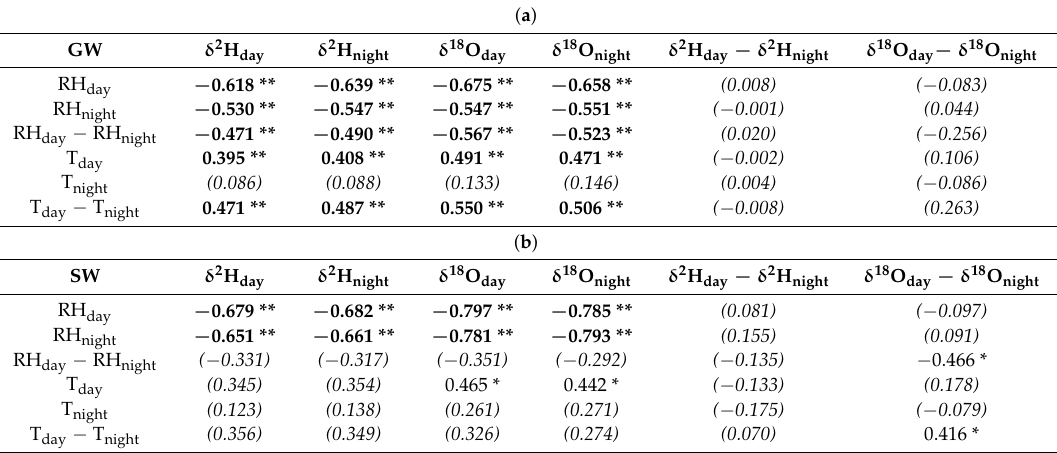
Figure 10. Frequency of the occurrence of the event (day enriched), calculated with bootstrapping, for the δ 2 H and δ 18 O isotopes for groundwater (GW) and surface water (SW). The bars show the confidence intervals between the 0.05 and 0.95 p -values. The 50% frequency is marked by a horizontal dashed line (0.5). Table 2. Correlations between relative humidity (RH) or temperature (T) for different combinations of daily/nightly average values and their differences, and daily/nightly isotopic values ( δ 2 H and δ 18 O) in groundwater (GW) (a) and in surface water (SW)